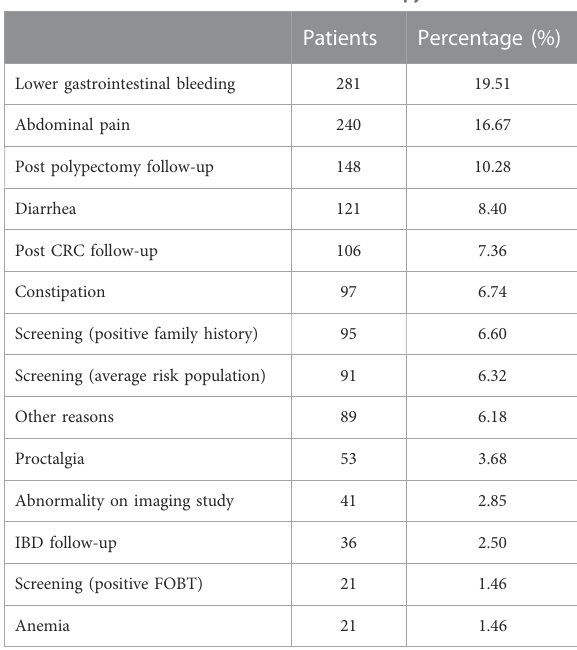
TABLE 2 List of recorded indications for